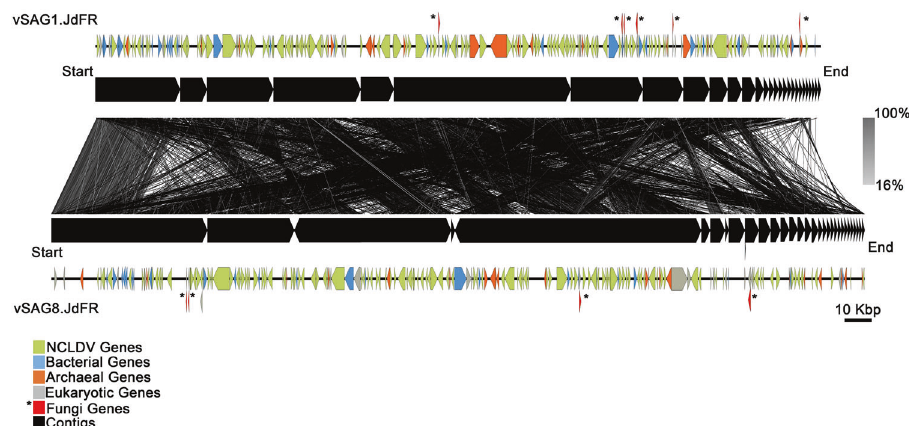
Fig. 1 Nucleotide level alignment of vSAG1.JdFR and vSAG8.JdFR to each other. The vSAG1.JdFR (28 scaffolds) and vSAG8.JdFR (33 scaffolds). Black tick marks denote the breaks between the concatenated (using 10 Ns) scaffolds. The lines between the vSAG1.JdFR and vSAG8.JdFR genomes represent the nucleotide level alignment based on tBlastx analysis (alignment ranging from 16 to 100%). The predicted genes were assigned taxonomic af fi liation based on Blastp analysis. Genes af fi liated to bacteria (blue), archaea (orange), NCLDV (green), eukaryotes (gray), fungal (red), and scaffolds (black) for vSAG1.JdFR and vSAG8.JdFR on the